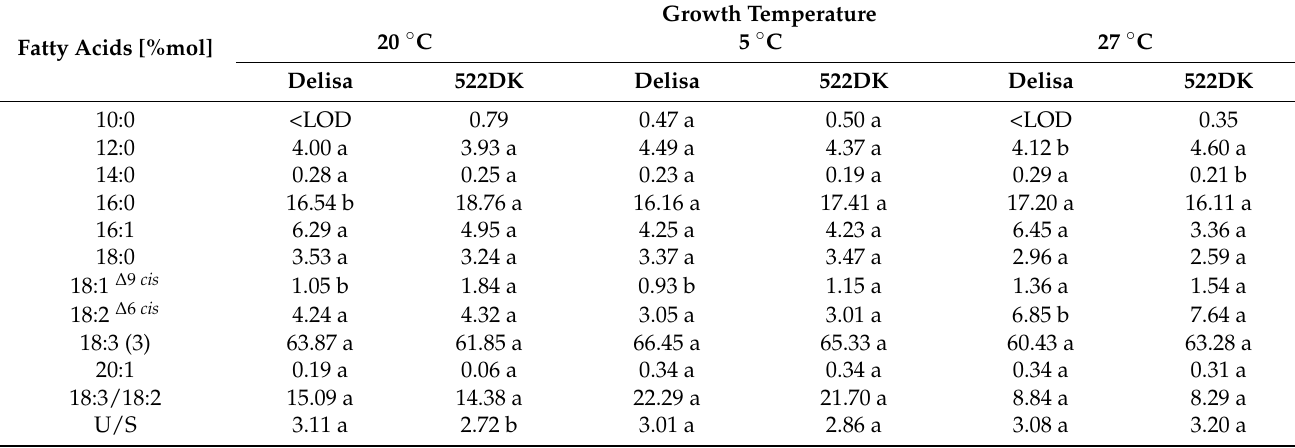
Table 1. Composition of the fatty acids of the chloroplast membranes isolated from the barley wild-type Delisa and its 522DK mutant cultured at 20 ◦ C, 5 ◦ C, and 27 ◦ C. Any significant differences between Delisa and the mutant (Student’s t-test, p ≤ 0.05) for each temperature are indicated by different letters. <LOD—below limit of